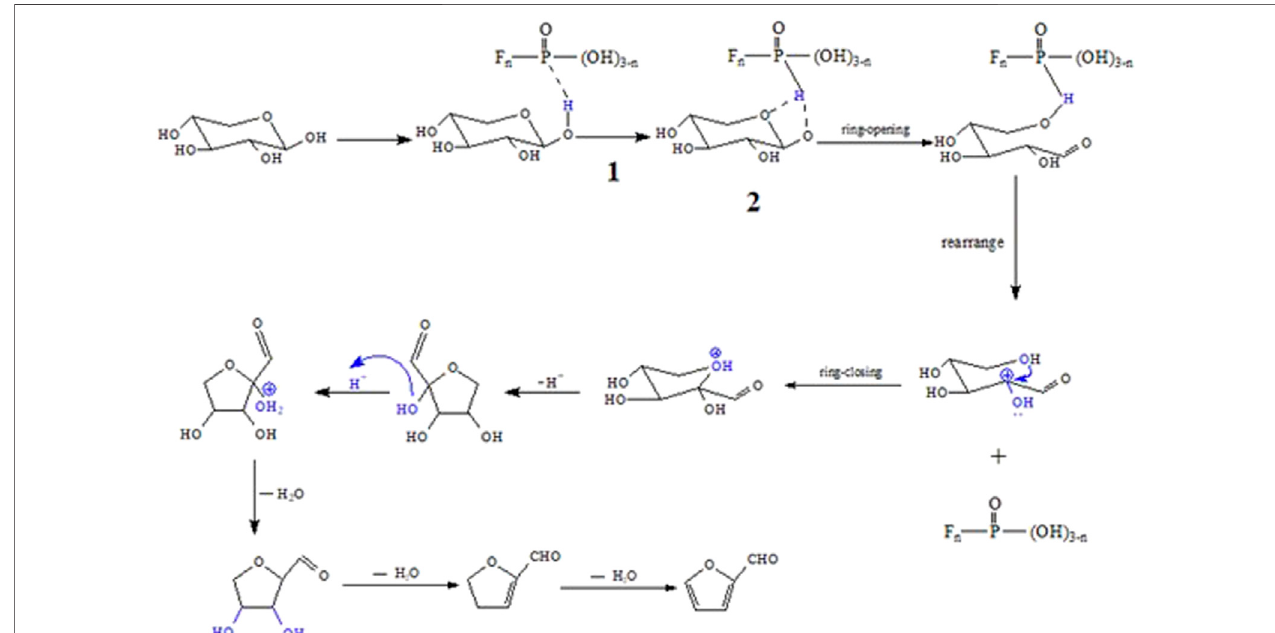
FIGURE 7 | Possible mechanism of the conversion of xylose to furfural catalyzed by C n MF in water.